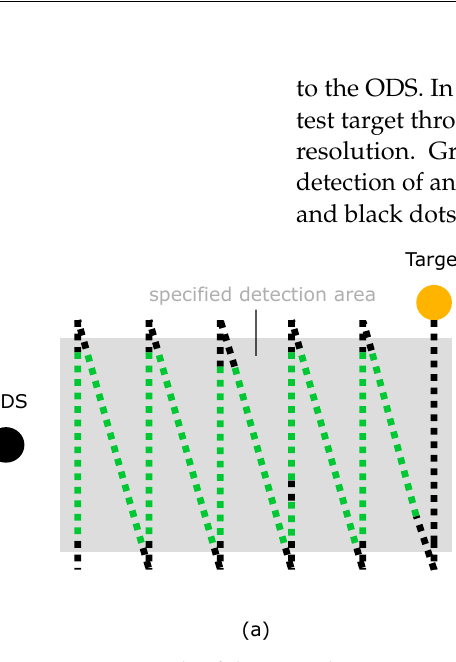
Figure 9. Records of the second test scenario: ( a ) The detections from the ODS are recorded with green dots when the test target enters laterally and passes through the SDA perpendicular to the sensor. No detections of the ODS are recorded as black dots. ( b ) The detections from the ODS are recorded with green dots during the longitudinal entry and passage of the test target through the SDA. No detections of the ODS are recorded as black dots.